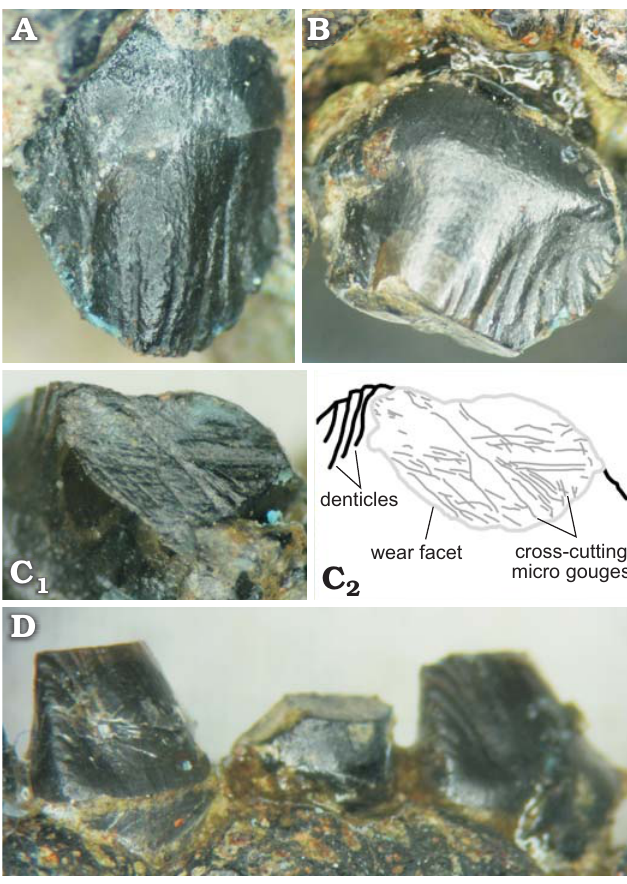
Fig. 10. Maxillary and dentary teeth of stegosaur GPDM 178 ( A – D ), near Giffen, Cascade County, Montana; C 2 , explanatory drawing showing the wear facet and cross-cutting gouges. Not to scale, anteroposterior wear facet length of approximately 2–2.5